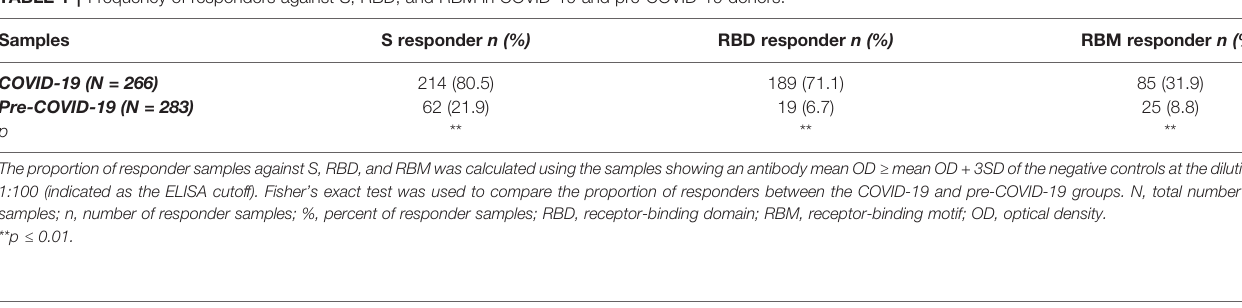
TABLE 1 | Frequency of responders against S, RBD, and RBM in COVID-19 and pre-COVID-19 donors. Samples